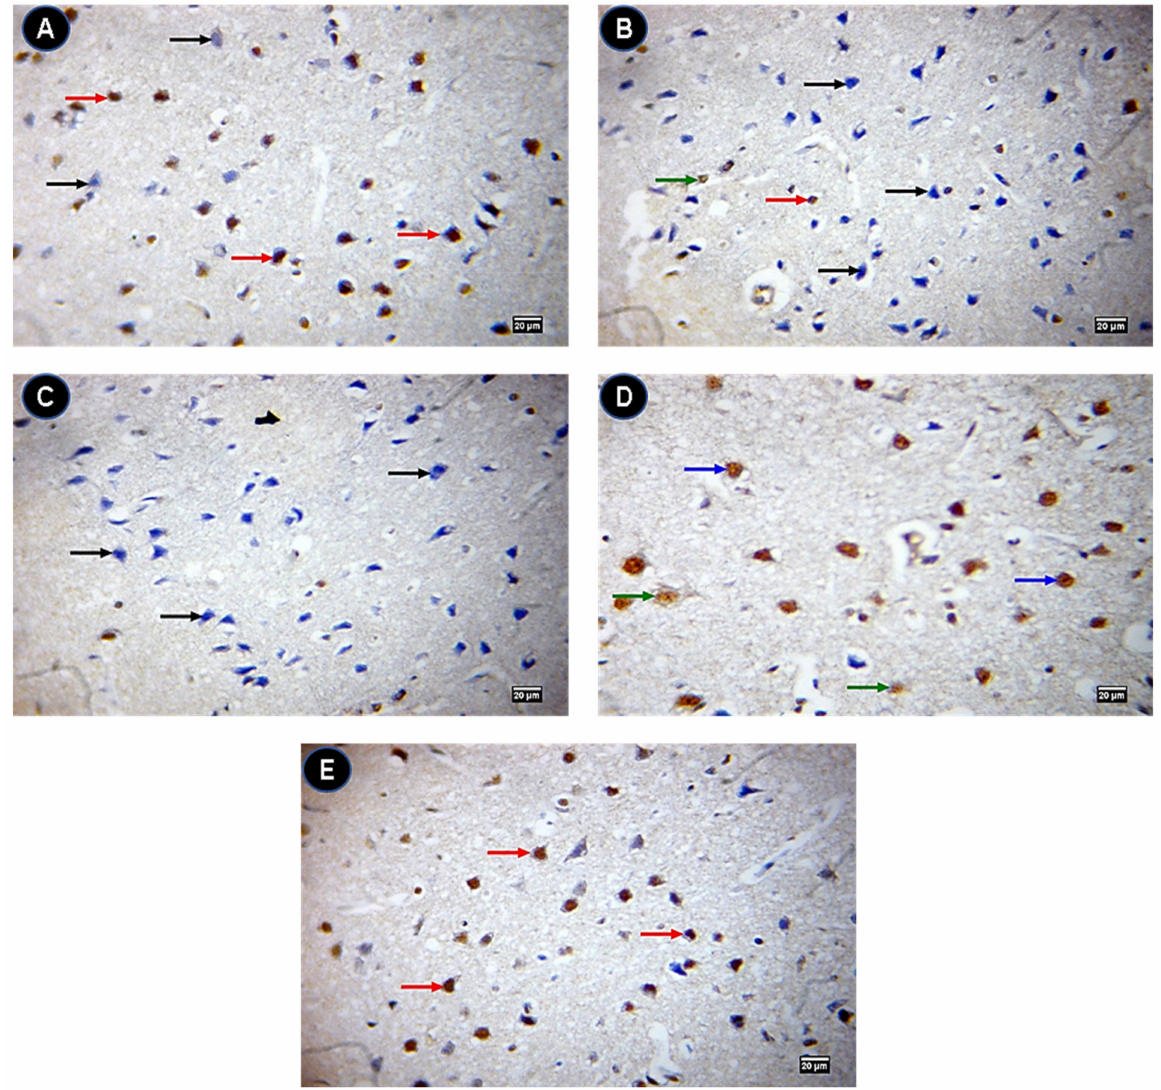
Figure 9. Immunohistochemistry of Bcl2 in brain tissue. ( A ) Control group showing negative (black arrow) and strong (red arrow) Bcl2 positive brown immunostained neurons. ( B ) IONPs group showing negative (black arrows) and a few strong (red arrows) and weak (green arrow) Bcl2 positive brown immunostained neurons. ( C ) IONPs + Q25 group showing negative (black arrows) Bcl2 brown immunostained neurons. ( D ) IONPs + Q50 group showing moderate (blue arrows) and weak (green arrows) Bcl2 positive brown immunostained neurons. ( E ) IONPs + Q100 group showing strong (red arrows) Bcl2 positive brown immunostained neurons. × 400. Scale bar = 20 µ